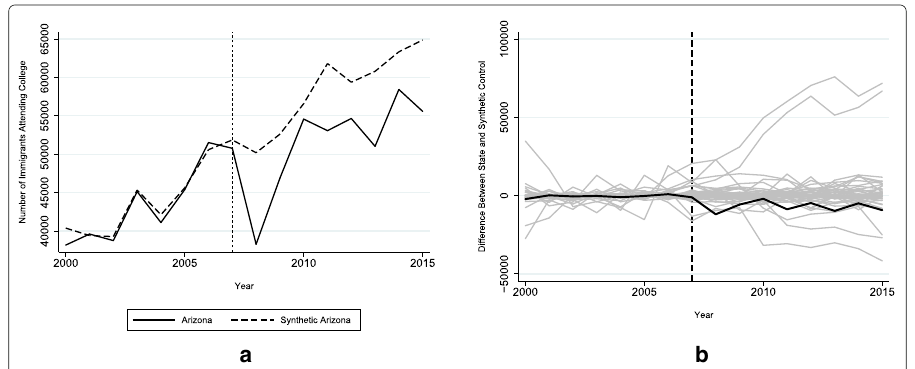
Fig. 3 LAWA and number of immigrants in college. a Number of immigrants. b Permutation